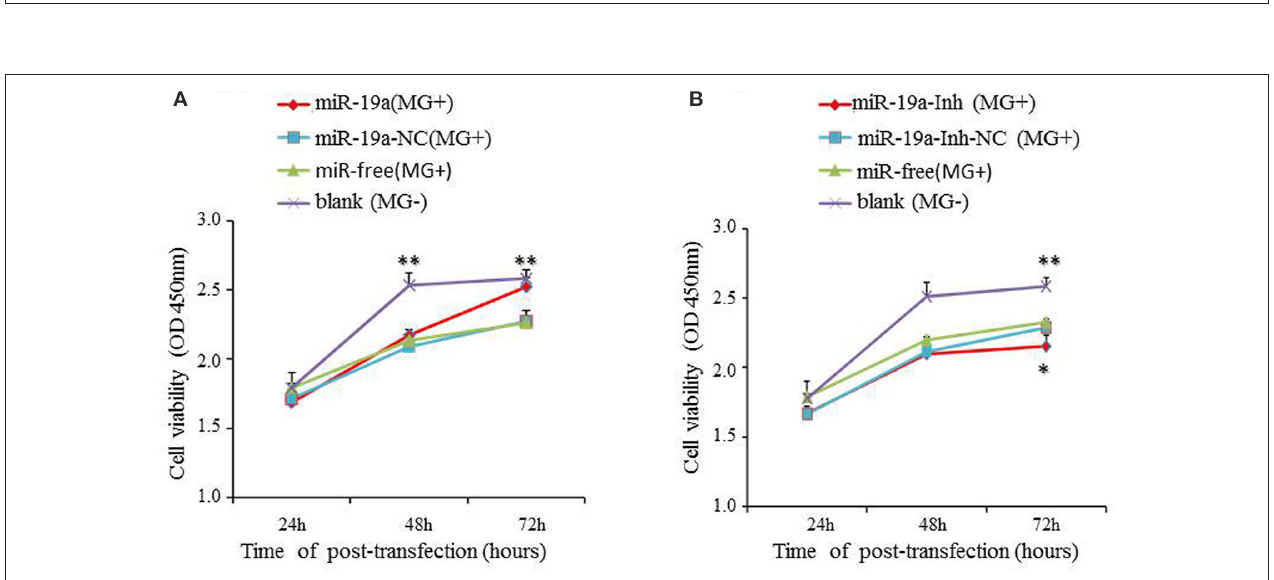
FIGURE 5 | The effect of gga-miR-19a on DF-1 cell proliferation. DF-1 cells were transfected with gga-miR-19a, miR-19a-NC, miR-19a-Inh or miR-19a-Inh-NC and were incubated for 4 h. The cells were then infected with the MG-HS strain. Four control groups, including miR-19a-NC (MG + ), miR-19a-Inh-NC (MG + ), miR-free (MG + ) and the blank (MG − ), were used. At 24, 48, and 72 h post-transfection, cell proliferation was detected using CCK-Cell Counting Kit-8a. All values are represented as the mean ± SD of three independent experiments in triplicate. The asterisks represented statistically significant differences (* P < 0.05, ** P < 0.01). (A) The over-expression of gga-miR-19a dramatically promotes DF-1 cell proliferation; (B) Inhibitor of gga-miR-19a inhibites the proliferation of DF-1 cells.